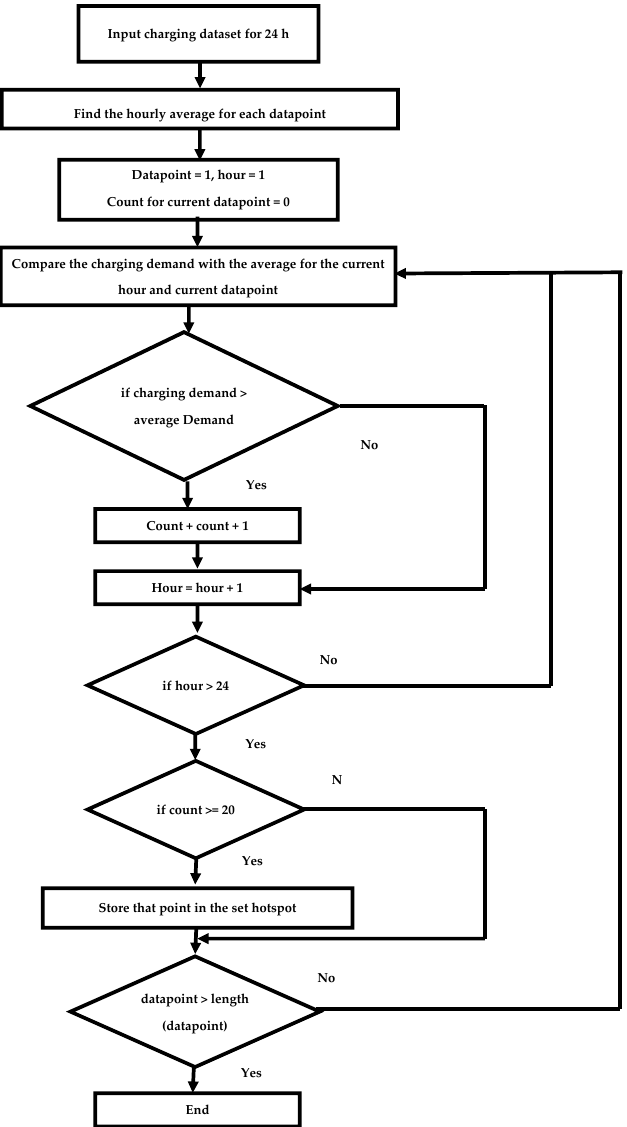
Figure 5. Flowchart for the computation of public commercial charging hotspots